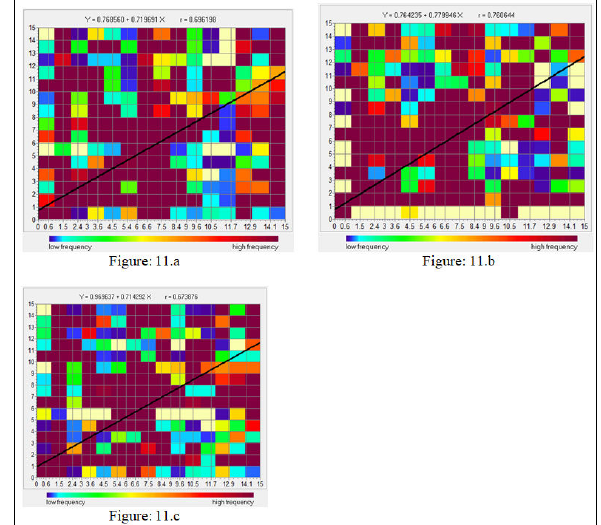
image; Figure 10.c. Relationships between predicted LULC of